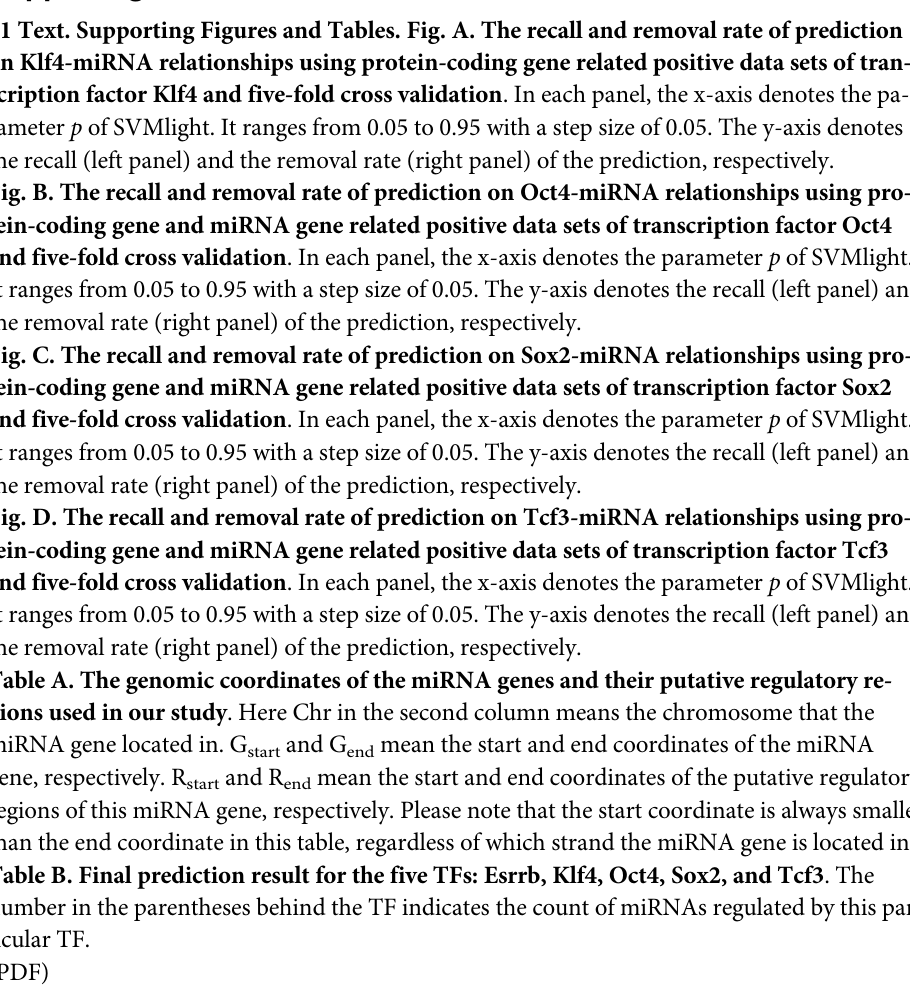
Table B. Final prediction result for the five TFs: Esrrb, Klf4, Oct4, Sox2, and Tcf3 . The number in the parentheses behind the TF indicates the count of miRNAs regulated by this par- ticular